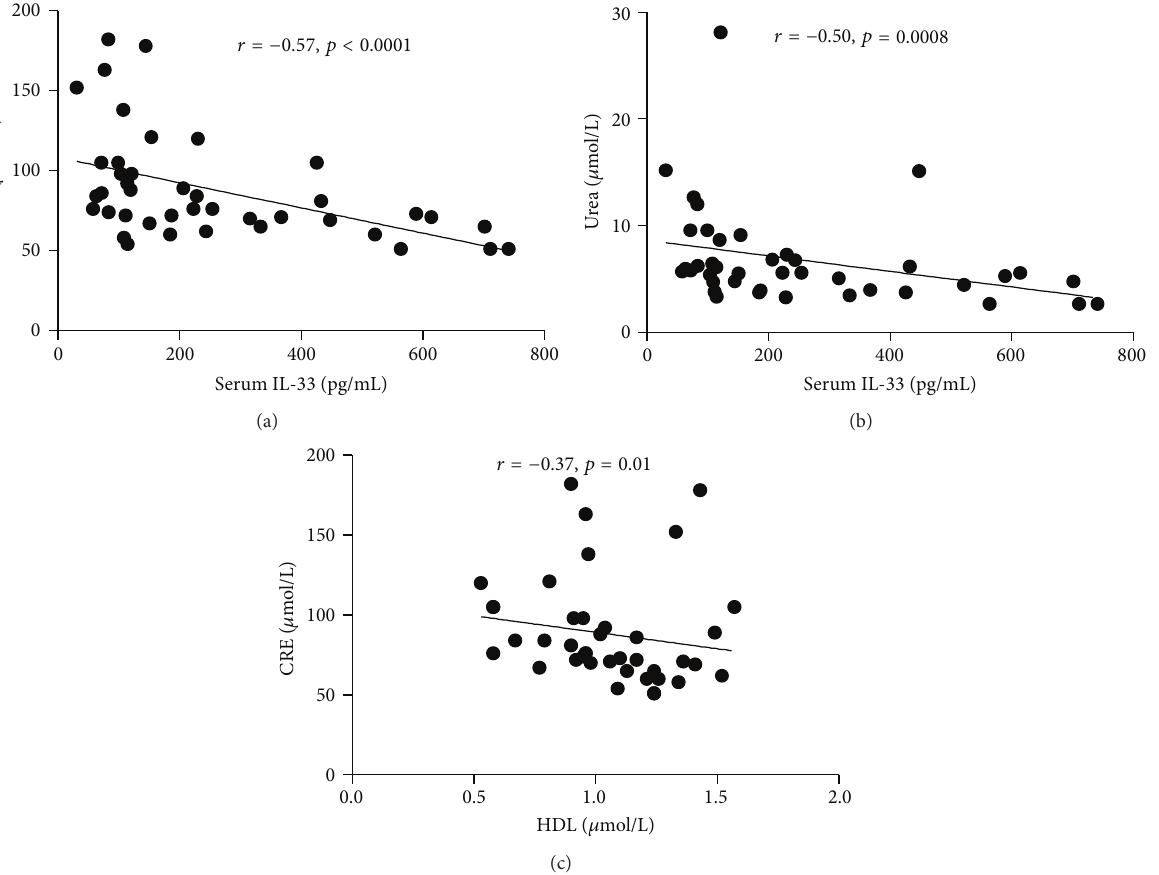
Figure 3: Negative correlation of IL-33 with CRE and urea in gout patients. (a, b) The determination of linear relationships between IL-33 expression and CRE and urea in gout patients was performed by Spearman correlation coefficient. (c) Serum HDL levels showed a negative correlation with Cre. Spearman’s correlation analysis was used to calculate